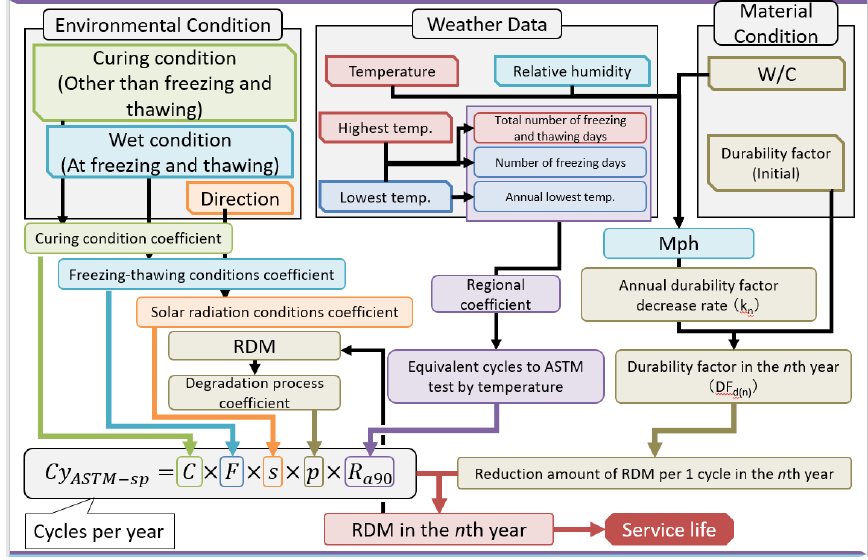
Figure 1. Overall flowchart for the calculation process.